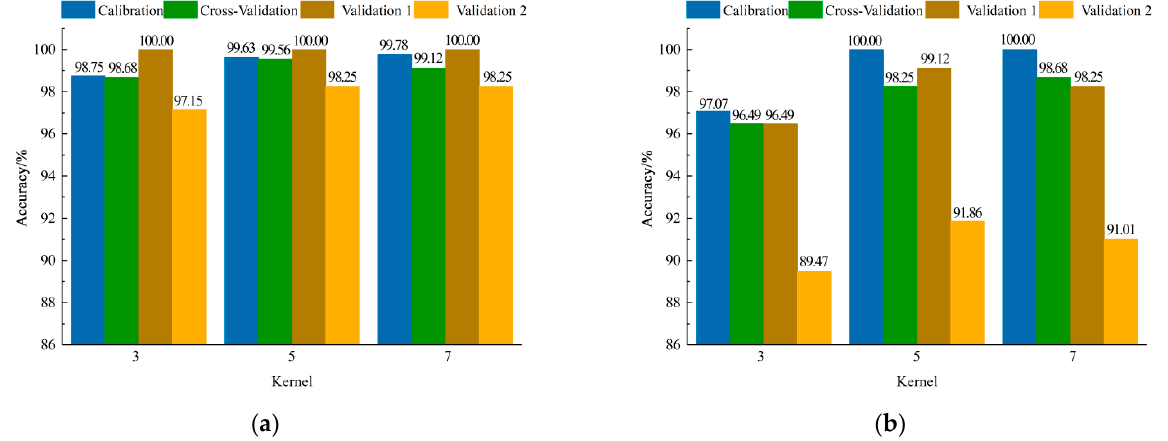
Figure 6. Results of CNN-Softmax models with different convolution kernel sizes based on mean spectral information ( a ) per direction and of ( b ) four directions.